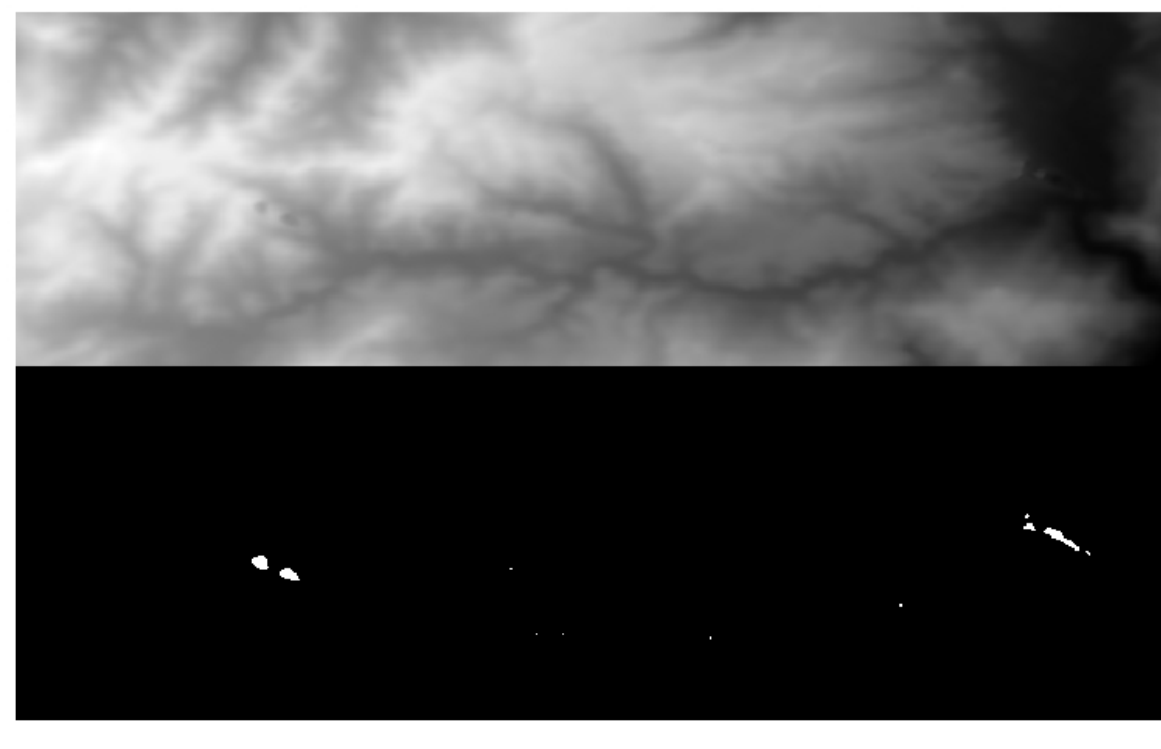
Figure 15. Outlier regions corresponding to the area indicated in Figure 14 with red polygon; ASTER GDEM (top) and corresponding outliers